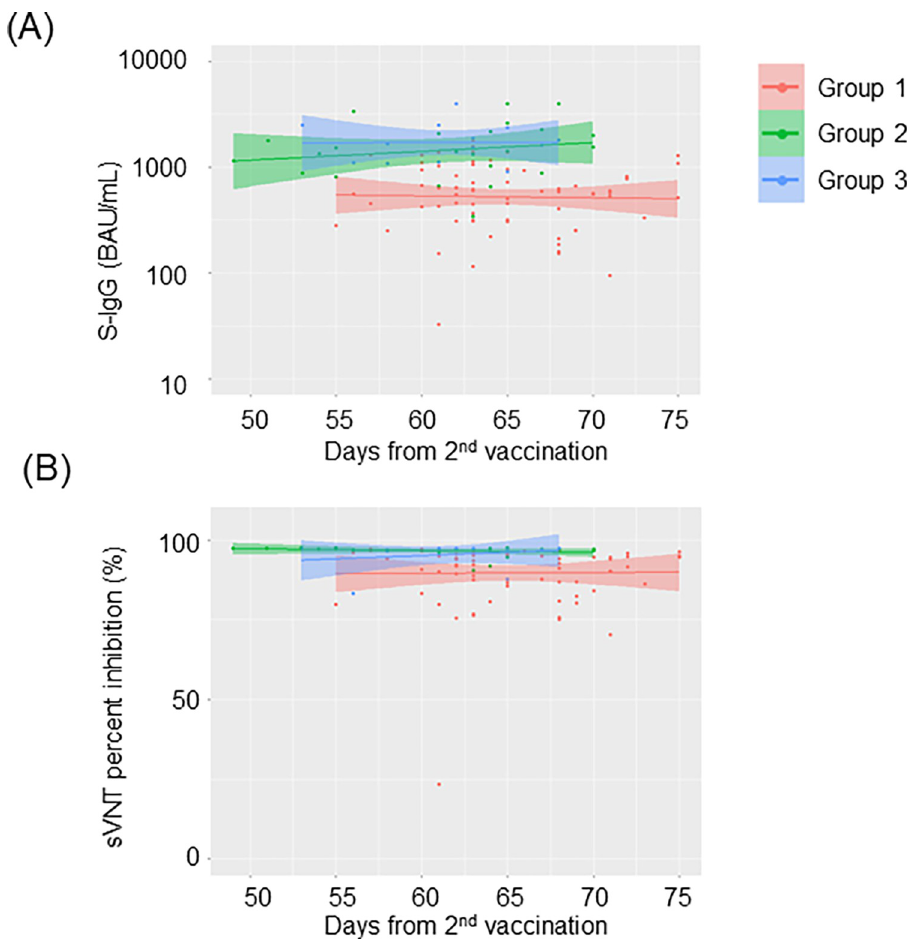
Fig 6. Change in VITROS S-IgG and cPass sVNT titers over time after second